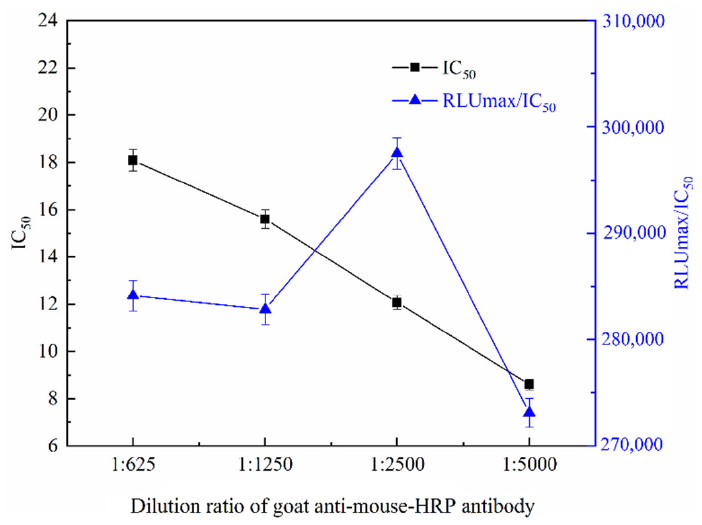
Figure 4. The IC 50 and RLUmax/IC 50 of ic-CLIEA with different goat anti-mouse-HRP antibody dilution ratios for ACE detection.